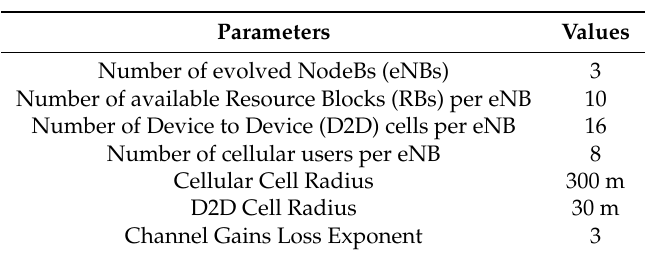
Table 1. Simulation